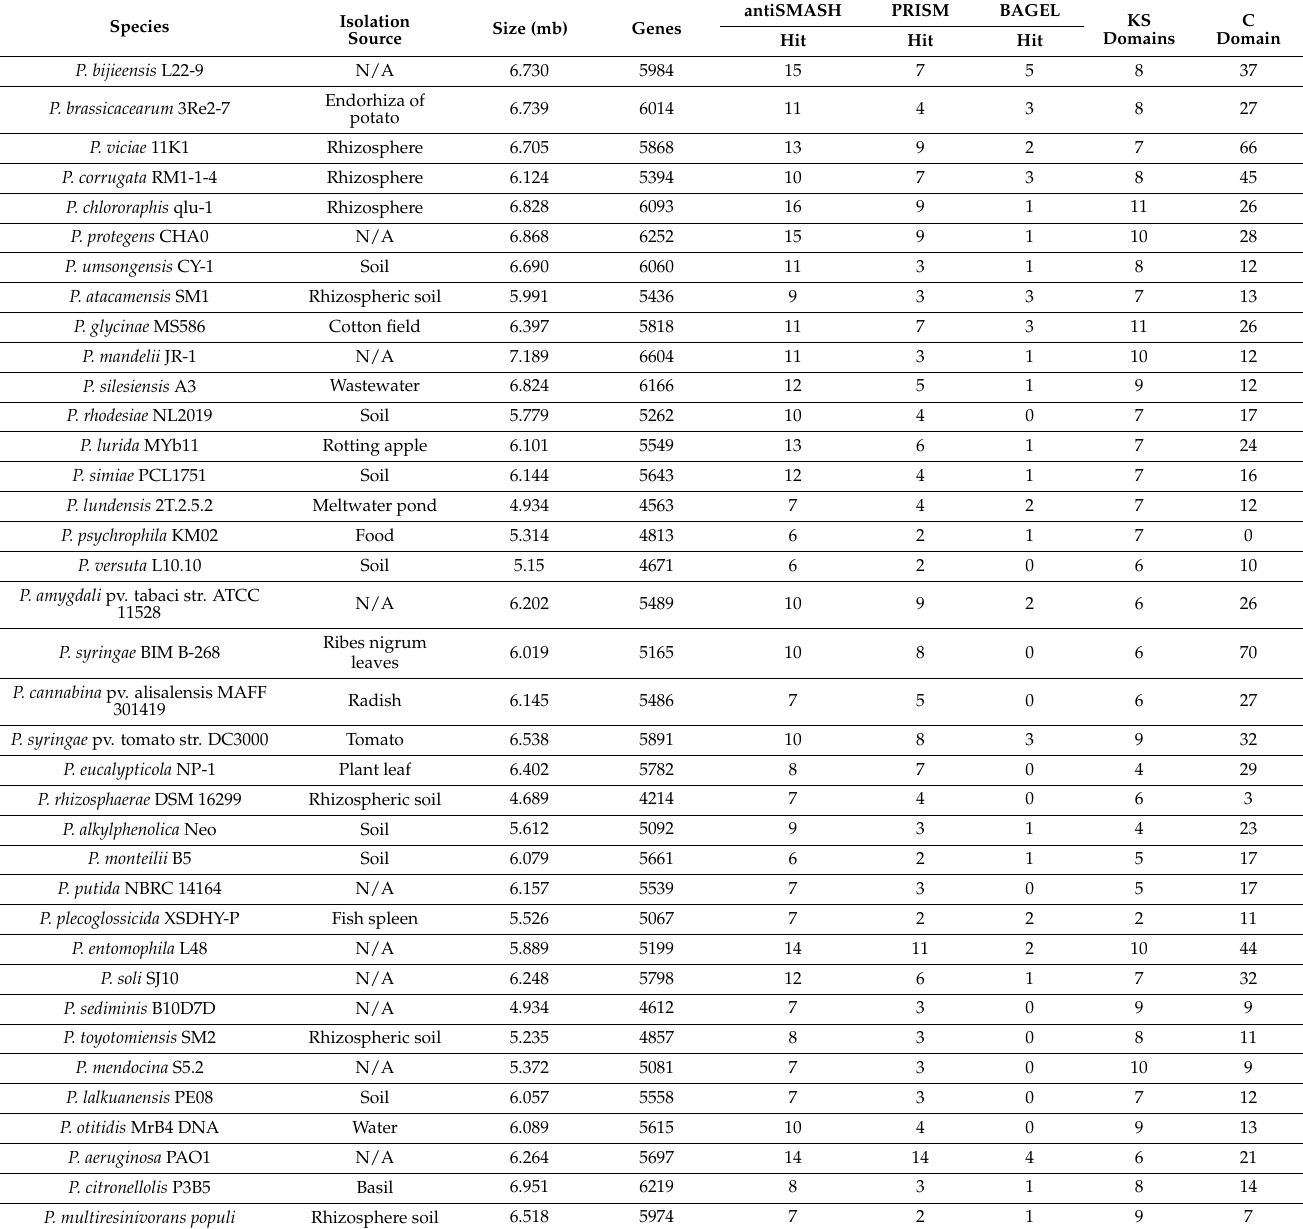
Table 1. Reference genomes of Pseudomonas species studied with different hits from different genome mining tools for